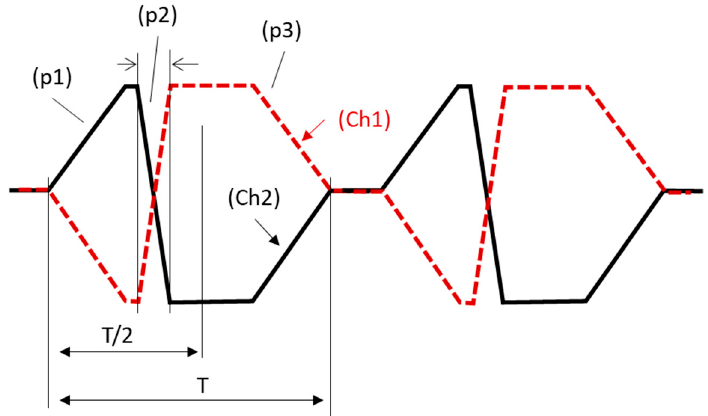
Figure 4. Motor driving signal waveforms of an “anticyclic” nature. Phase 2 (p2), which corresponds to the slip time, is not to scale. Before and after the stick and slip times, there are regions where the voltage levels are constant.